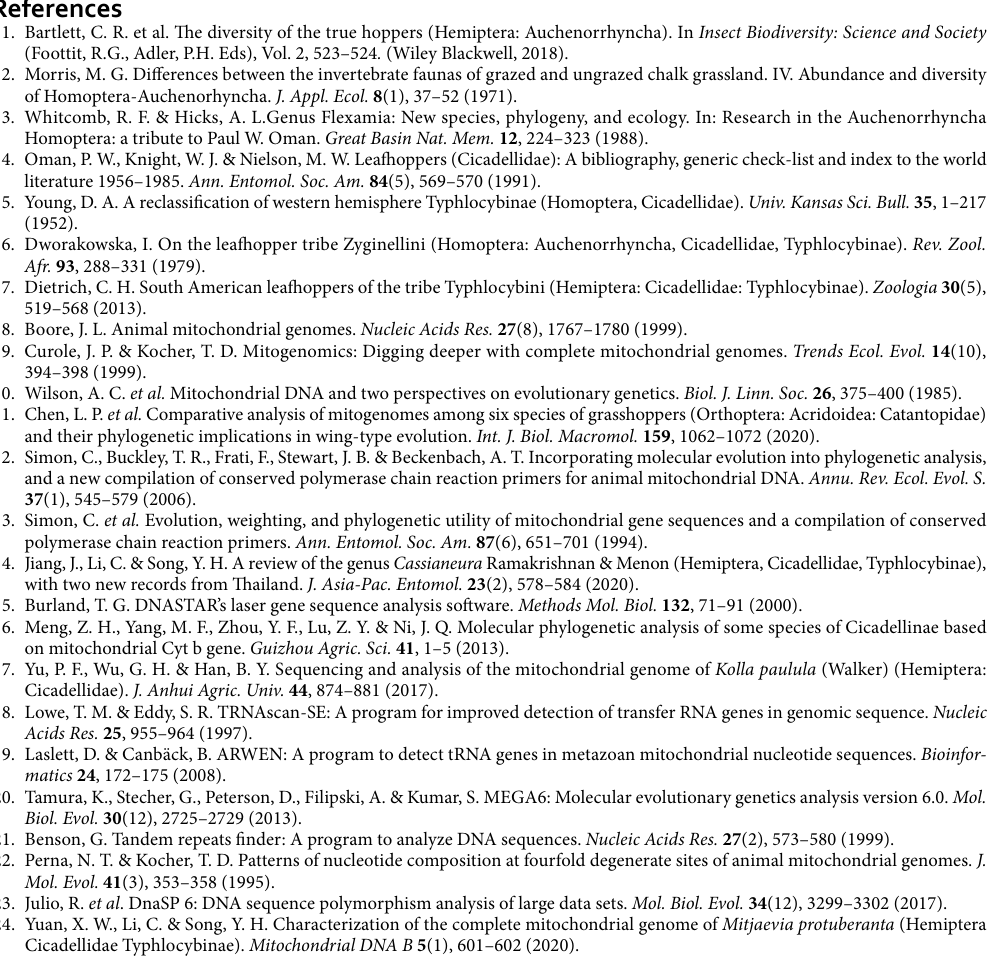
provide further comparative data on the mitogenomes of Typhlocybinae and suggest that morphological and mitogenome data provide consistent phylogenetic signal useful for elucidating relationships among genera and tribes of this diverse group of plant-feeding insects.